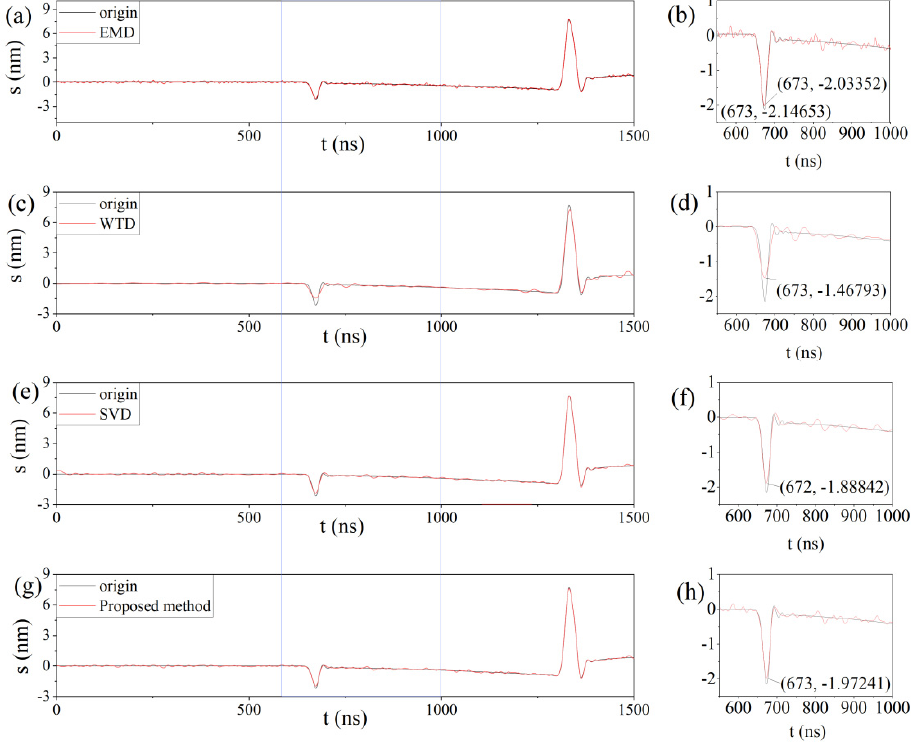
Figure 6. The comparison results of different denoising methods. ( a , c , e , g ) represents the original signal and the signal after signal processing by various methods respectively; ( b , d , f , h ) are the corresponding partial enlargements. Table 3. Comparison results of denoising indicators when SNRin = 15 dB.